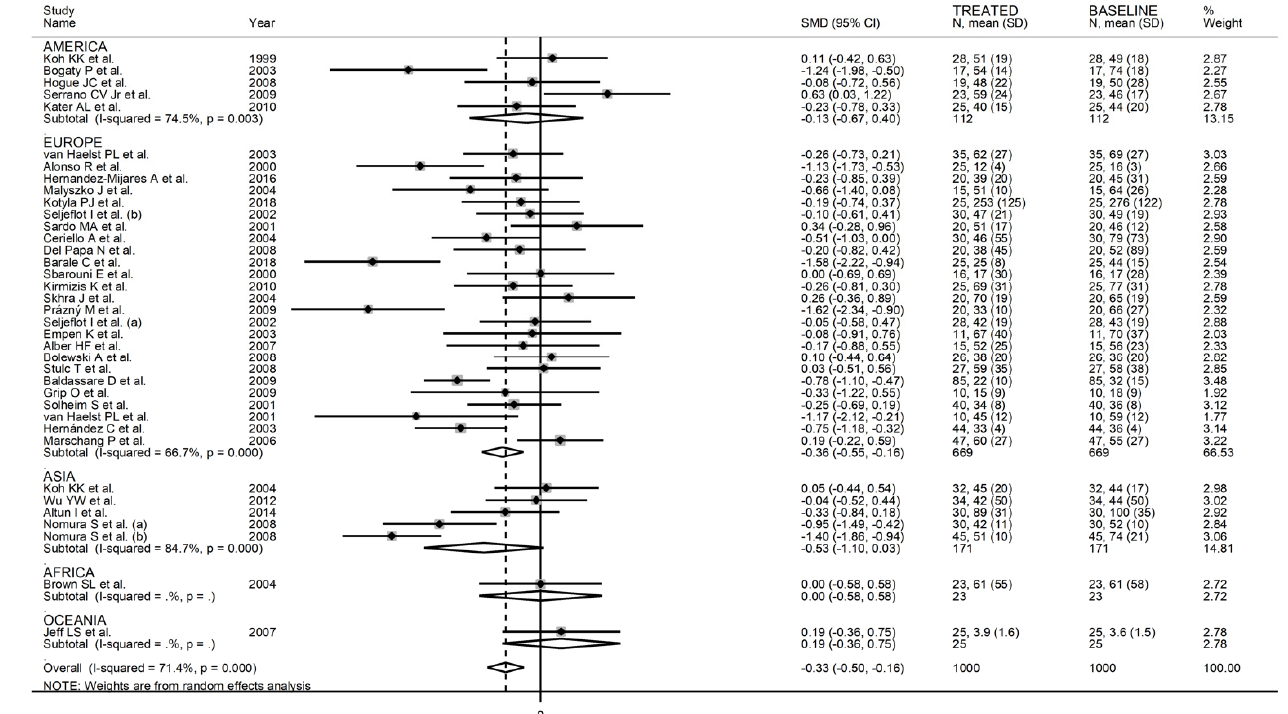
Figure 16. Forest plot of E-Selectin concentrations before and after statin treatment according to the continent where the study was conducted.